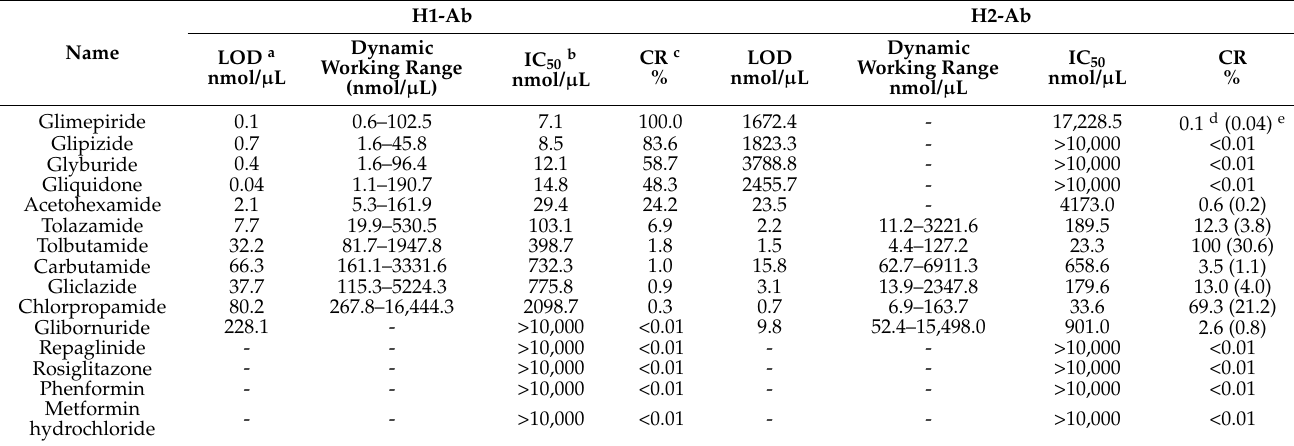
Table 2. Specificity and sensitivity of the ic-ELISA.